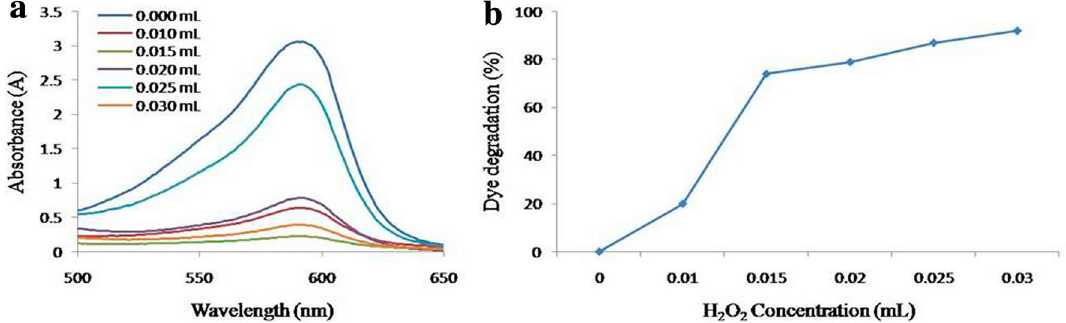
Fig. 8 a UV–Vis spectra of bromophenol blue photodegraded via TiO various concentrations of